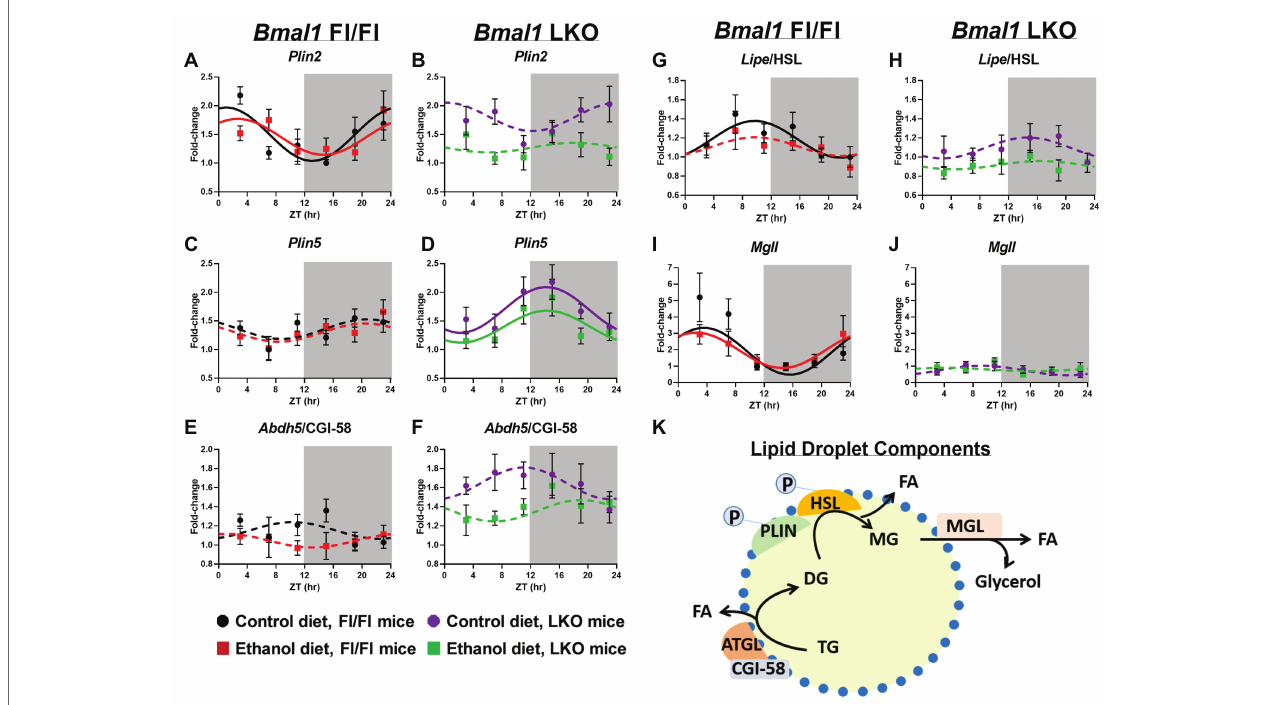
FIGURE 8 | Chronic alcohol and liver clock disruption alter diurnal mRNA rhythms of lipid droplet-associated genes. Diurnal mRNA profiles of lipid droplet genes Perilipin 2 ( Plin2 ; A,B ), Perilipin 5 ( Plin5 ; C,D ), Abhydrolase domain containing 5/Comparative Gene Interaction-58 ( Abdh5 /CGI-58; E,F ), Hormone sensitive lipase ( Lipe /HSL; G,H ), and Monoacylglycerol lipase ( Mgll ; I,J ) were measured in livers of control-fed (black) and alcohol-fed (red) Bmal1 Flox/Flox (Fl/Fl) and control-fed (purple) and alcohol-fed (green) Bmal1 liver-specific knockout (LKO) mice at ZT 3, 7, 11, 15, 19, and 23 (ZT 0: lights on/inactive period, ZT12: lights off/active period, gray area) by RT-PCR. Data are presented as a fold-change to the Bmal1 Fl/Fl control diet trough time-point and normalized to Ppia . Data are expressed as mean ± SEM for n = 4–8 mice/ genotype/diet/time point. Solid lines indicate rhythmic mRNA levels and a significant cosine fit, whereas dashed lines indicate arrhythmicity and a non-significant cosine fit. Diagram of a lipid droplet and lipid droplet-associated turnover proteins and enzymes (K) . After phosphorylation, PLIN recruits lipases to the surface of the lipid droplet to initiate TG breakdown to glycerol and FA. Results for Cosinor and ANOVA analyses are provided in Supplementary Tables 4 and 7 ,